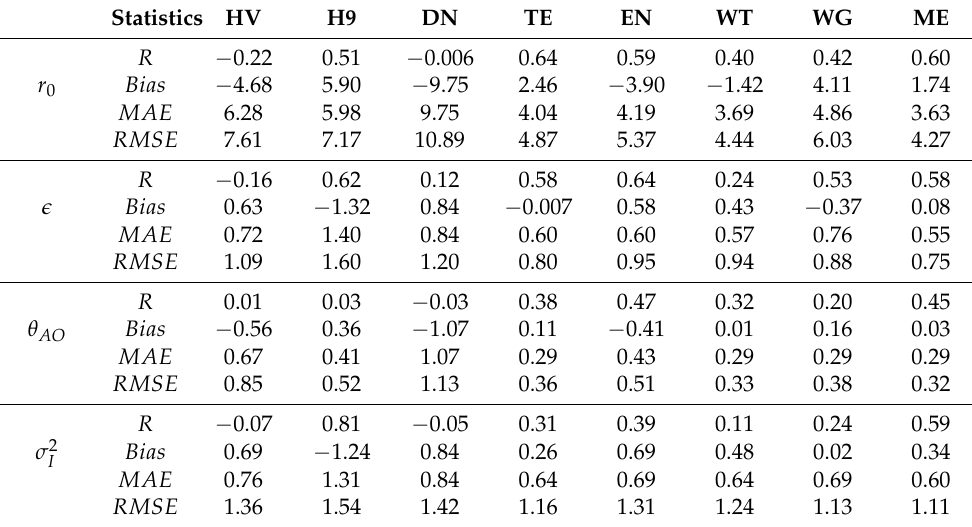
Table 5. NCACN integrated astronomical parameters statistics (@ λ = 550 nm).